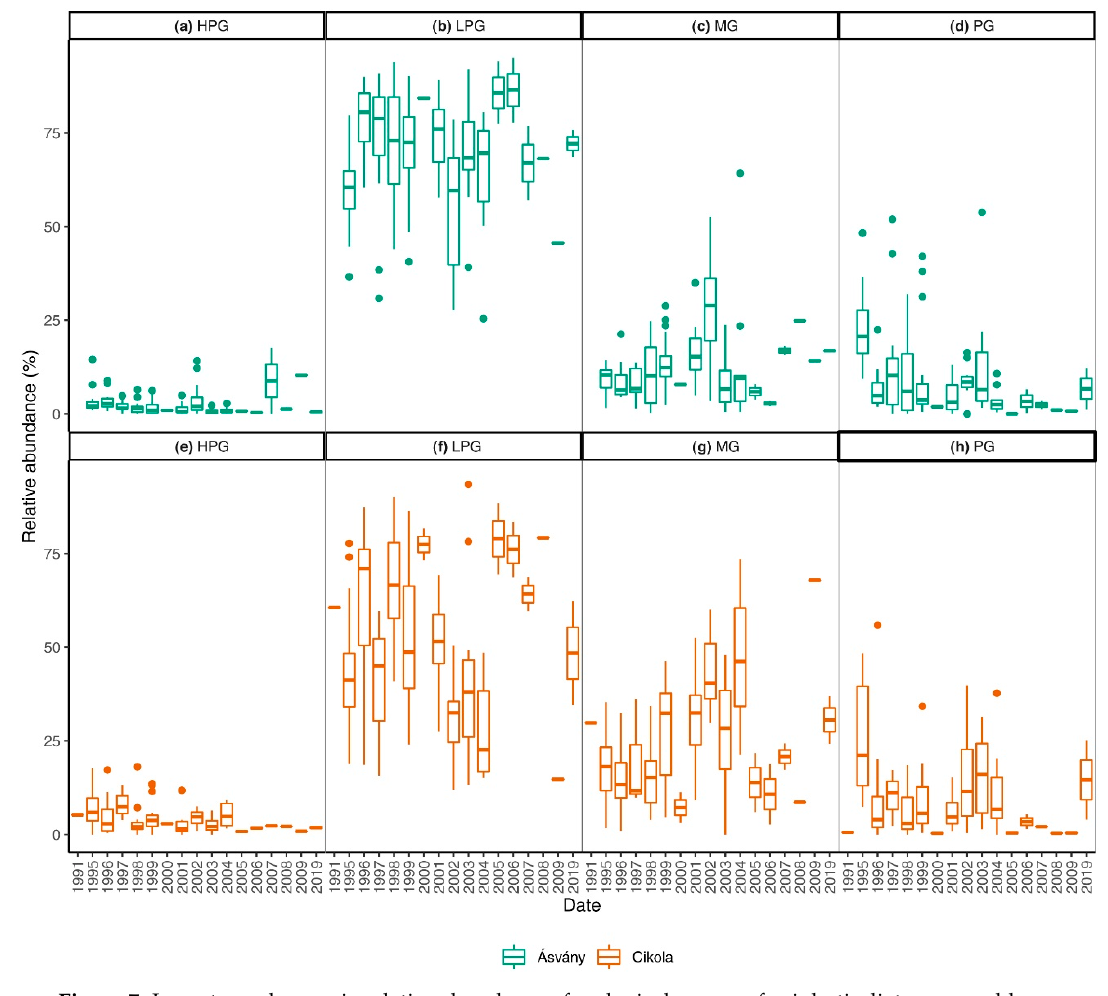
Figure 7. Long-term changes in relative abundance of ecological groups of epiphytic diatom assemblages from deployed and natural reeds at a4 and a6 ( a – d ) sampling sites in the Ásvány tributary system (green) and at c5 and c6 ( e – h ) sites in the Cikola tributary system (orange). HPG: high-profile group; LPG: low-profile group; MG: motile group; PG: planktonic group.